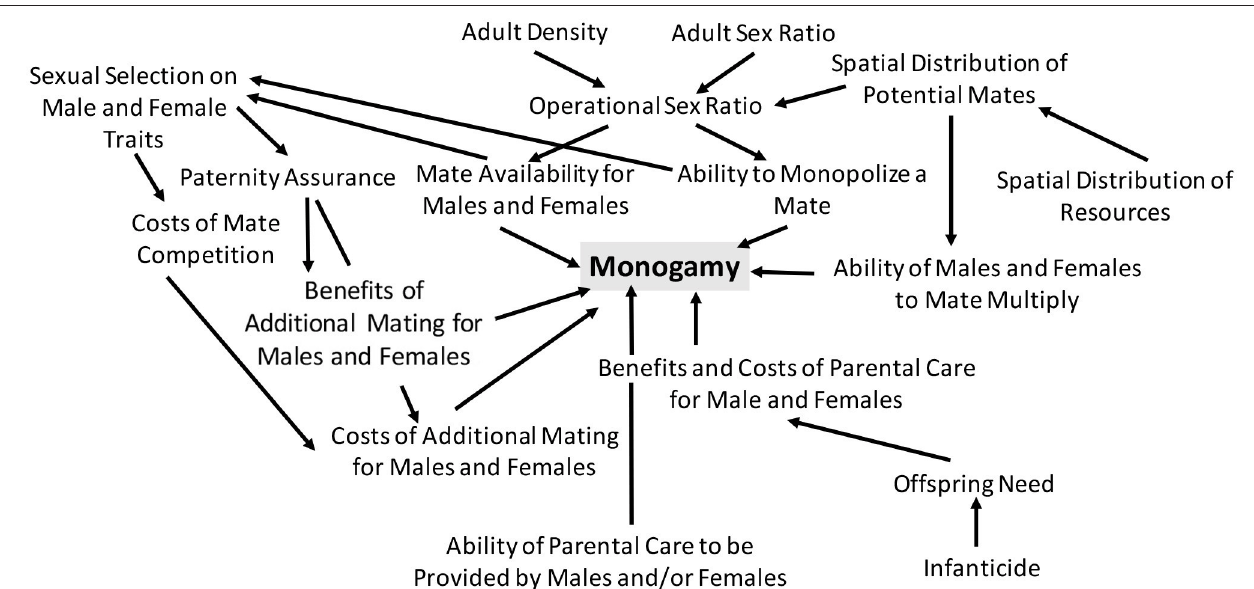
FIGURE 1 | It’s complicated! An overview of the factors hypothesized to influence monogamy. Numerous factors are expected to influence the presence or absence of monogamy in animals, which is why multiple hypotheses are required to understand the occurrence of monogamy in nature. Here, I illustrate some of the key factors that are expected to influence whether or not monogamy occurs. This is not an exhaustive list, as additional factors are expected to influence monogamy in some cases, and this figure does not illustrate the feedback that is expected to occur between the various factors depicted below, as well as the co-evolutionary feedback that is expected to occur among traits associated with mating, parental investment, and mate and resource